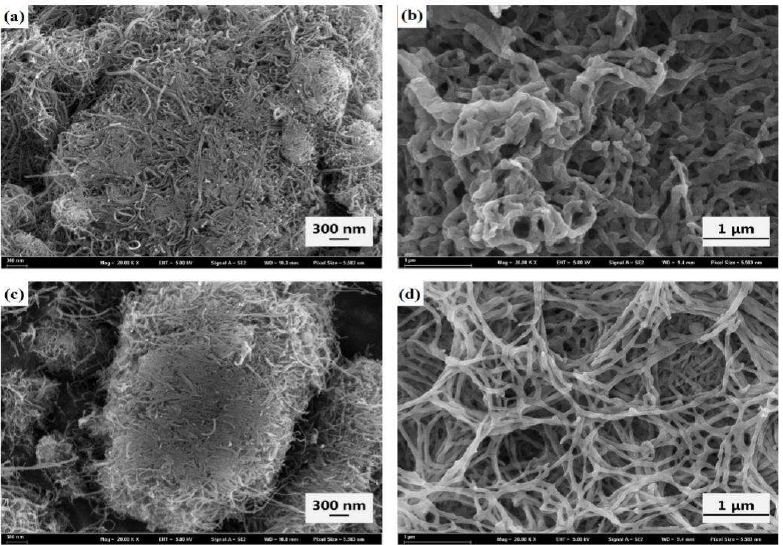
Figure 1. SEM images of the morphology of the CNT: ( a ) unmodified CNT and ( c ) modified CNT/PVP. SEM photographs of the surface morphology of the LC cells containing ( b ) unmodified CNT and ( d ) modified CNT/PVP.